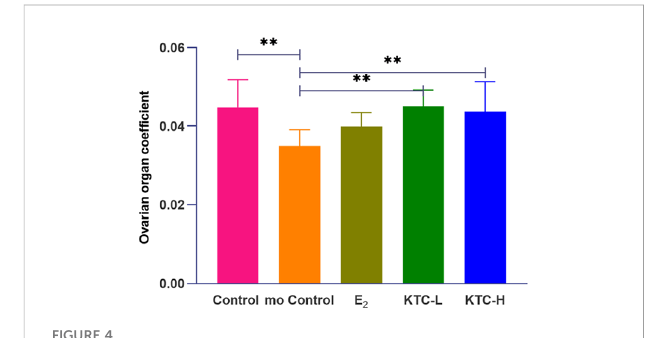
FIGURE 4 The fi ve groups ’ ovarian organ coef fi cient. ** P